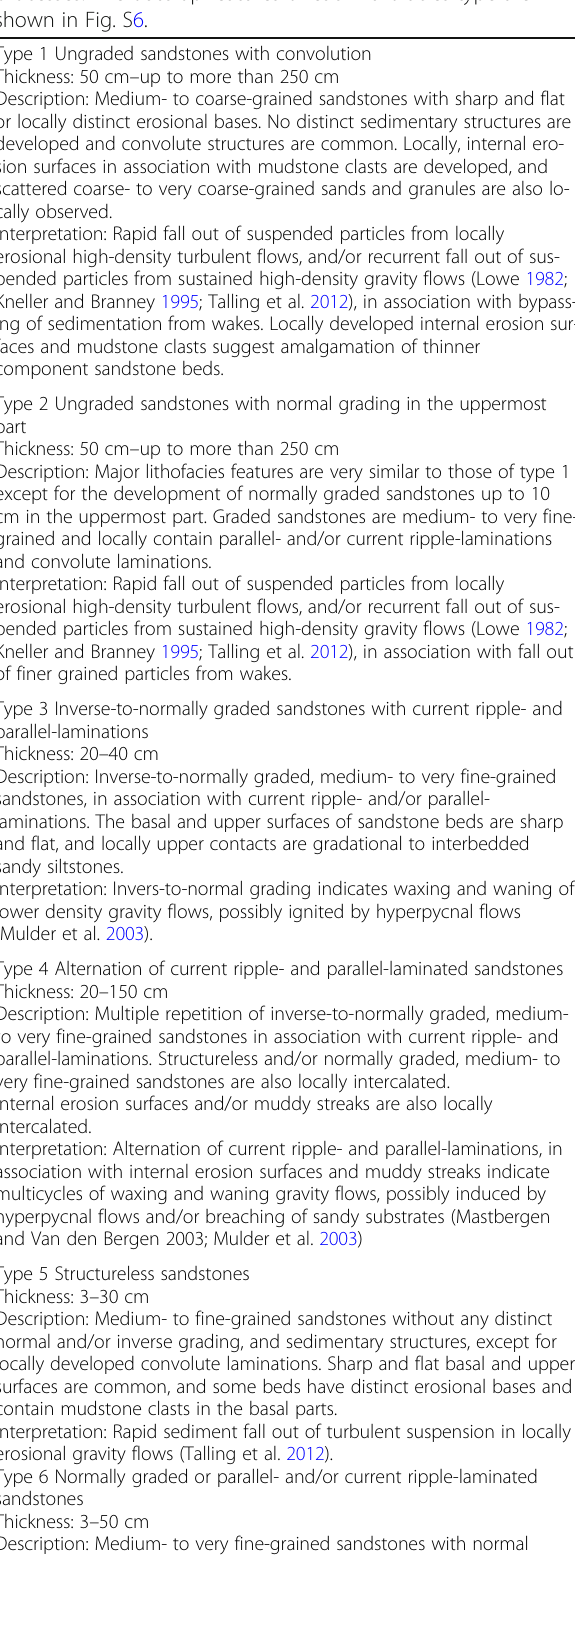
Table 1 Lithofacies types and their inferred